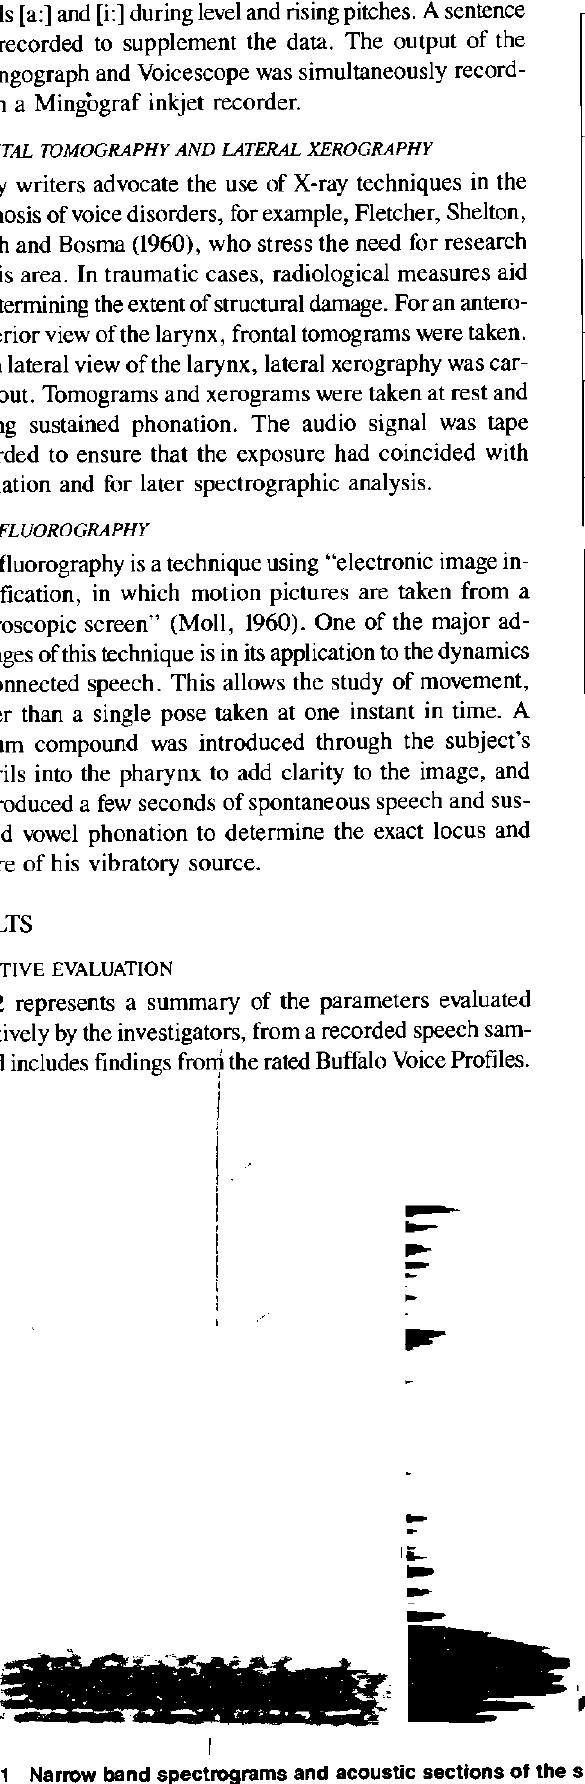
Figure 1 Narrow band spectrograms and acoustic sections of the sustained vowels [i:] and [a:]. Die Suid-Afrikaanse Tydskrif vir Kommunikasieafwykings, Vol. 31,